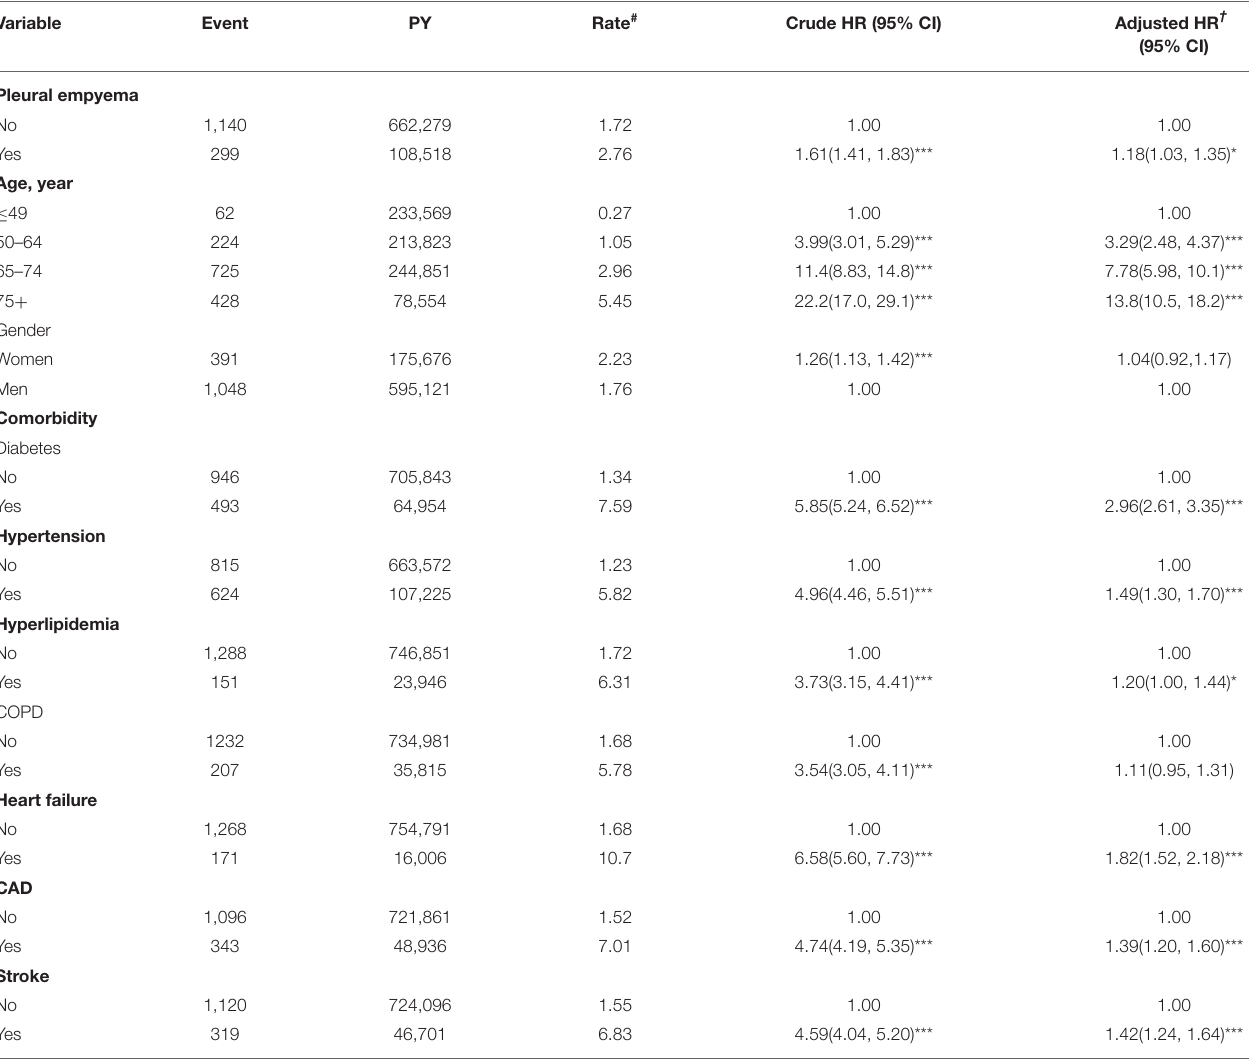
TABLE 2 | Incidence and hazard ratio for peripheral arterial disease and peripheral arterial disease-associated risk factor.